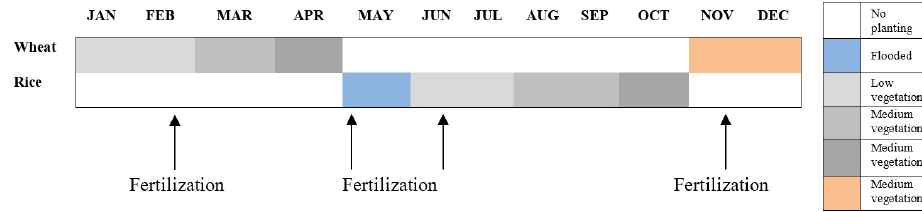
Figure 2. Crop calendars for the rice and wheat in the North Yangtze River Delta